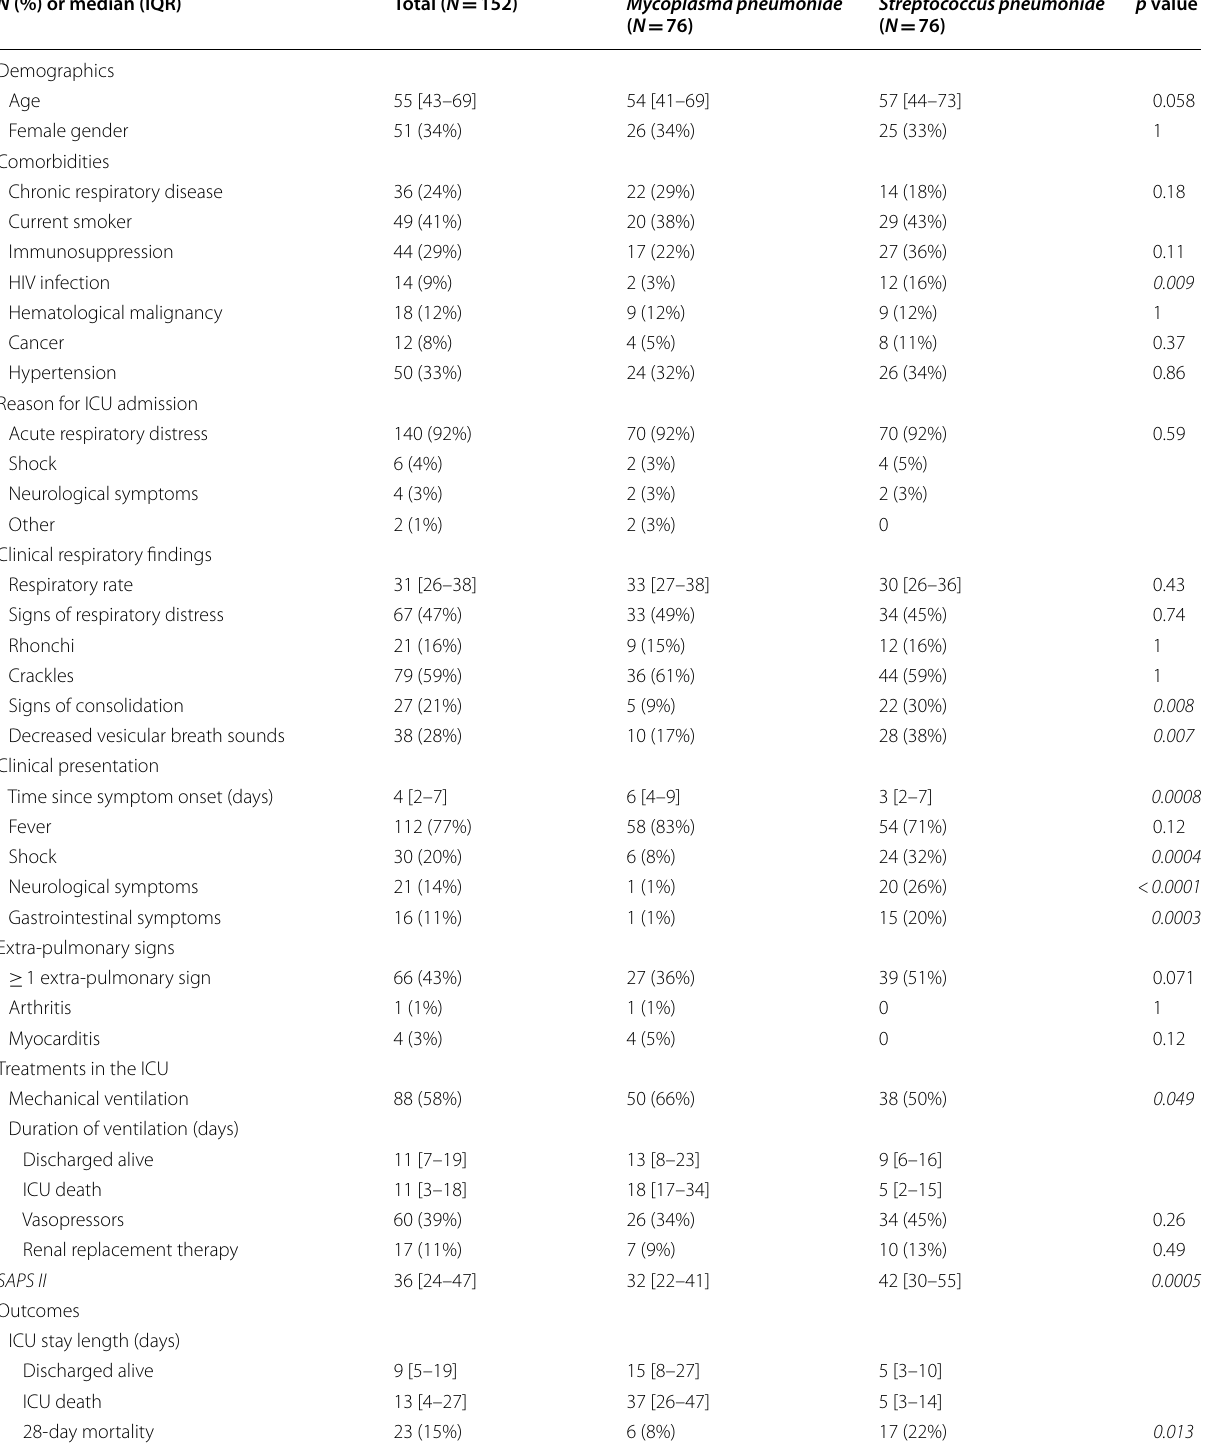
Table 2 Univariate analysis comparing clinical characteristics and outcomes of patients with Mycoplasma pneumoniae versus Streptococcus pneumoniae